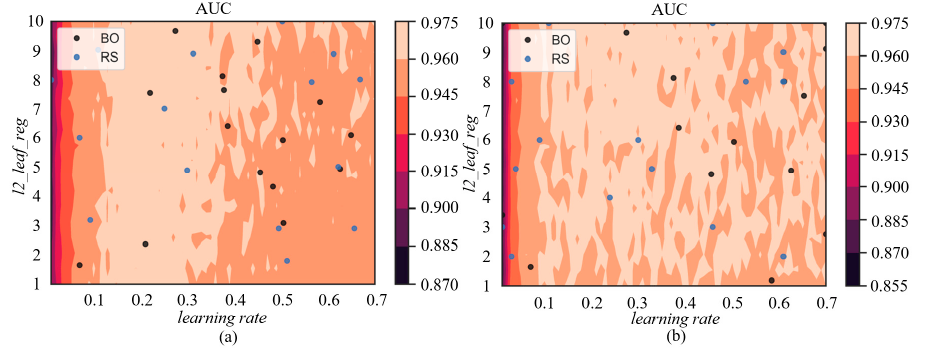
Figure 4. ( a ) Distribution of AUC impacted by learning rate and l2_leaf_reg on the 118-bus system;